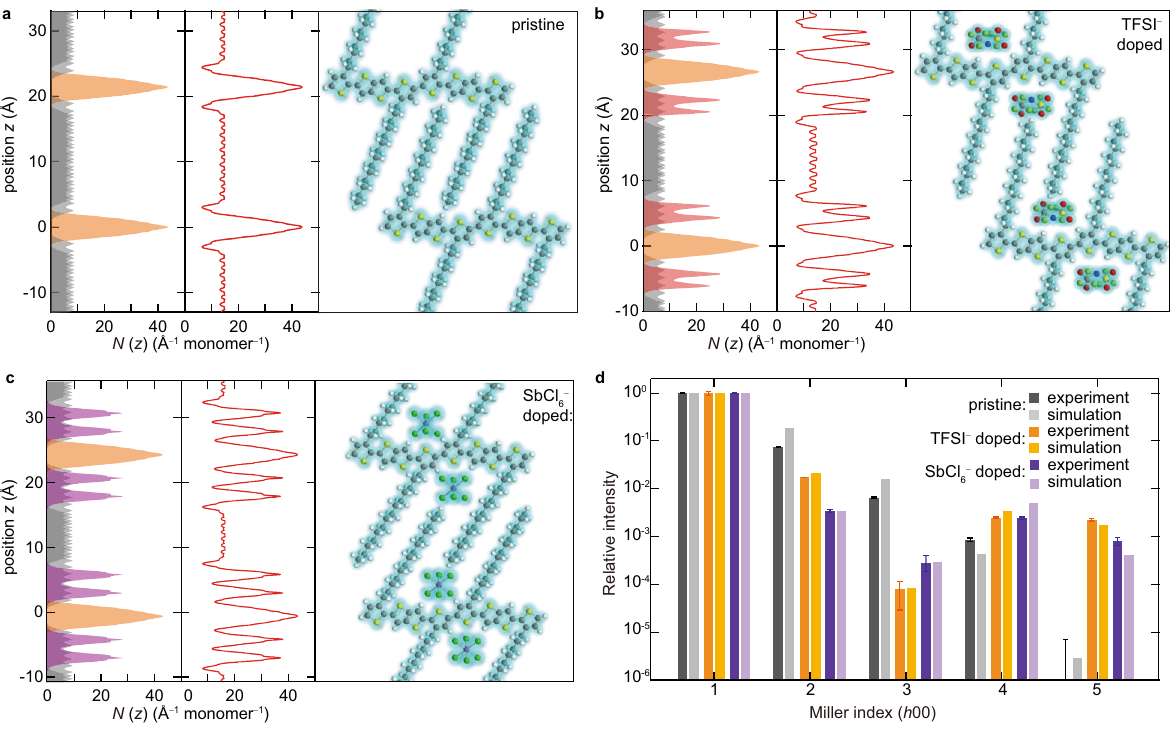
Fig. 3 Simulation of XRD peaks and structures of doped PBTTT. Models of ( a ) pristine PBTTT, ( b ) PBTTT doped with TFSI anion, and ( c ) PBTTT doped with SbCl 6 anion, obtained from our simulations. The models are shown as side views, where the left axis represents the position in the out-of-plane direction. Left panels: Electron density pro fi les, N ( z ), for the repeating motifs for the PBTTT backbone (orange), alkyl chains (gray), TFSI anions (red), and SbCl 6 anions (purple). Middle panels: Electron density pro fi les, N ( z ), for the repeating motifs integrated for all the components. Right panels: Side views of the modeled PBTTT and chemically doped PBTTT obtained from our simulations. d Comparison of experimentally obtained and simulated intensities of h 00 ð Þ diffraction peaks for pristine and chemically doped PBTTT thin fi lms. The error bars in the experimentally obtained peak intensities were determined from uncertainties in the Gaussian fi tting of spectra and represent one standard